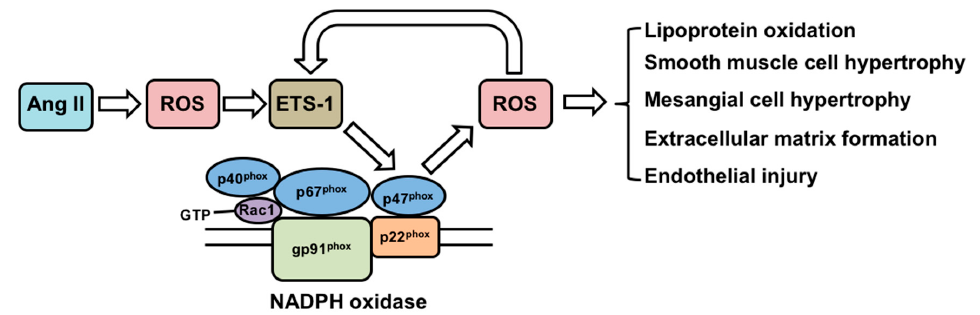
Figure 2. Regulation of ETS-1 by angiotensin II and the functional consequences. Ang II: Angiotensin II; ROS: reactive oxygen species; NADPH: nicotinamide adenine dinucleotide phosphate.